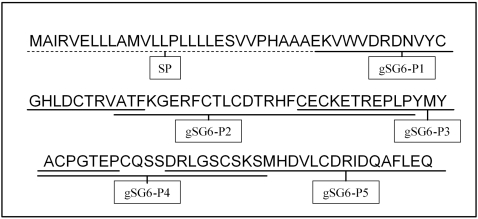
Amino-acid sequence of gSG6 Peptides.Amino-acid sequence of the SG6 protein of Anopheles gambiae (gi:13537666) is presented and sequences of the selected peptides, gSG6-P1 to gSG6-P5, are underlined. Signal peptide (SP) sequence is indicating by dotted underline.